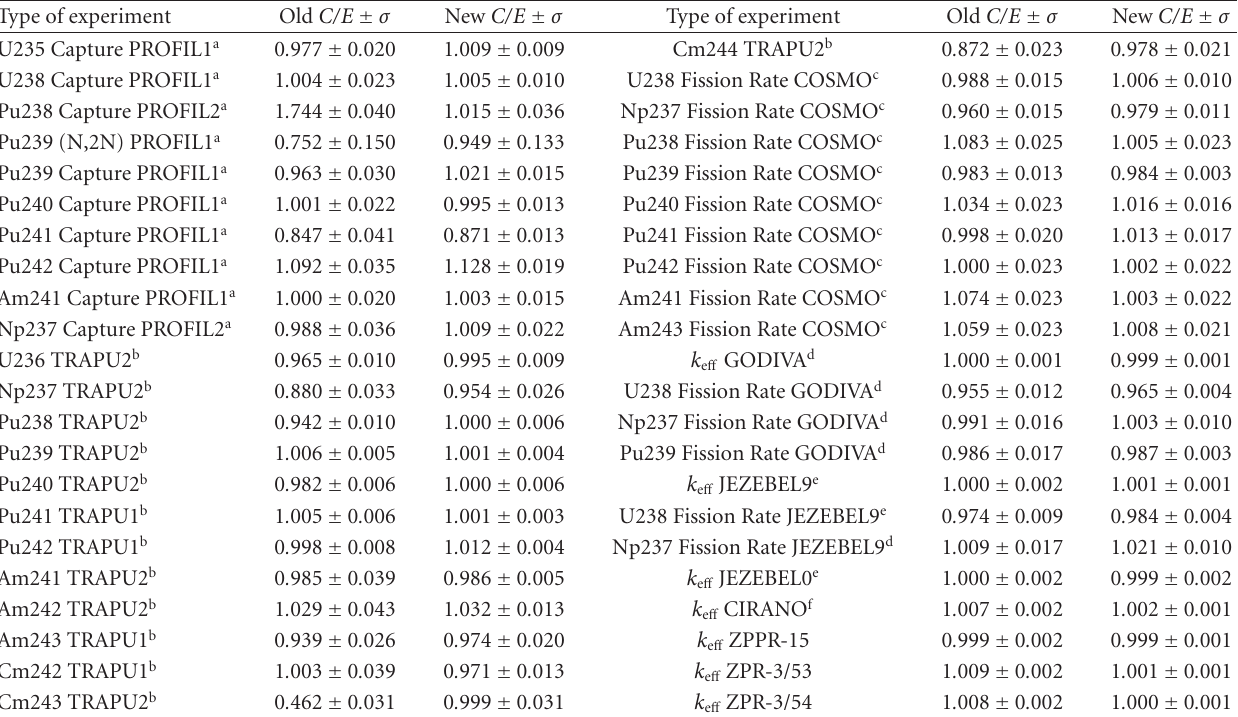
Table 4: C / E and associated uncertainties ( σ ) before and after